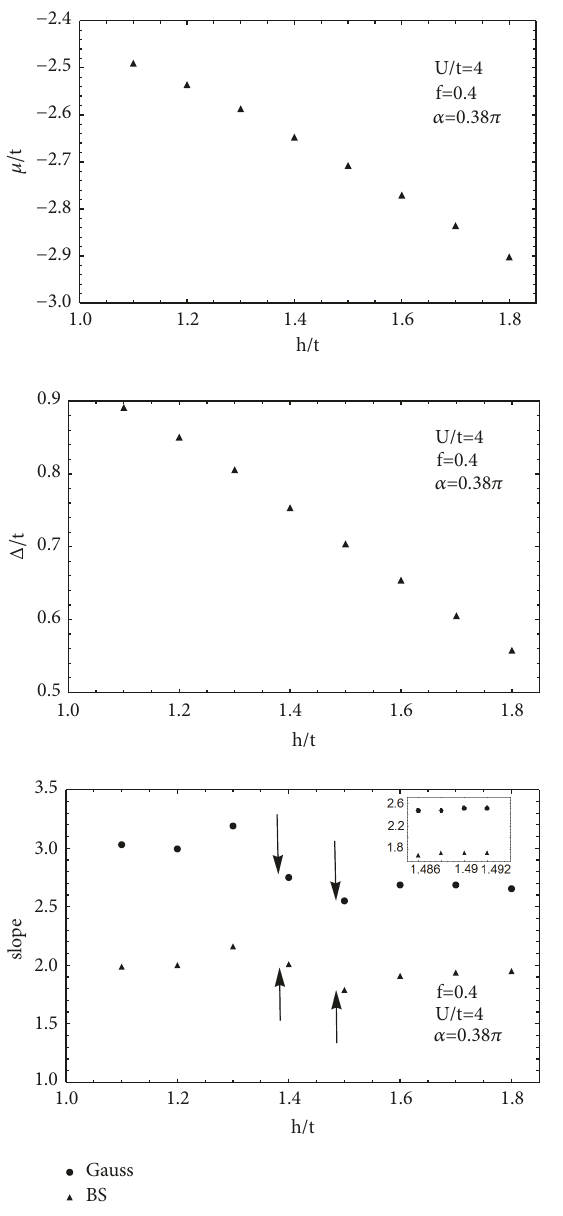
Figure 4: Chemical potential 𝜇 , pairing gap Δ , and the slope of the Goldstone sound mode of a Fermi gas in a square optical lattice subject to a non-Abelian gauge field with 𝛼 = 0.38𝜋 as a function of the Zeeman field ℎ . The chemical potential and the gap are obtained by solving the mean field number and gap equations (13)-(14). The arrows show the values of the Zeeman field for which the opening and closing of a gap take place. The insert shows the slope close to ℎ /𝑡 = 1.49 푐